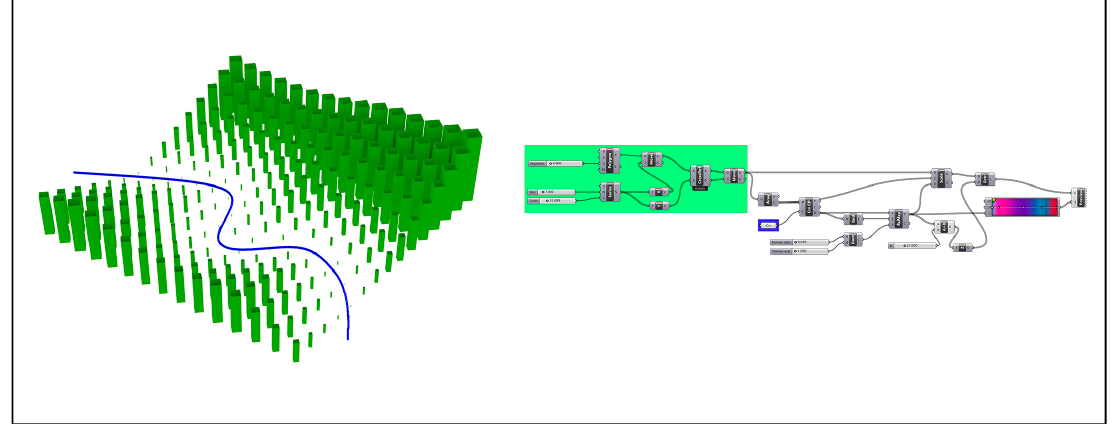
Figure 6. Attractive